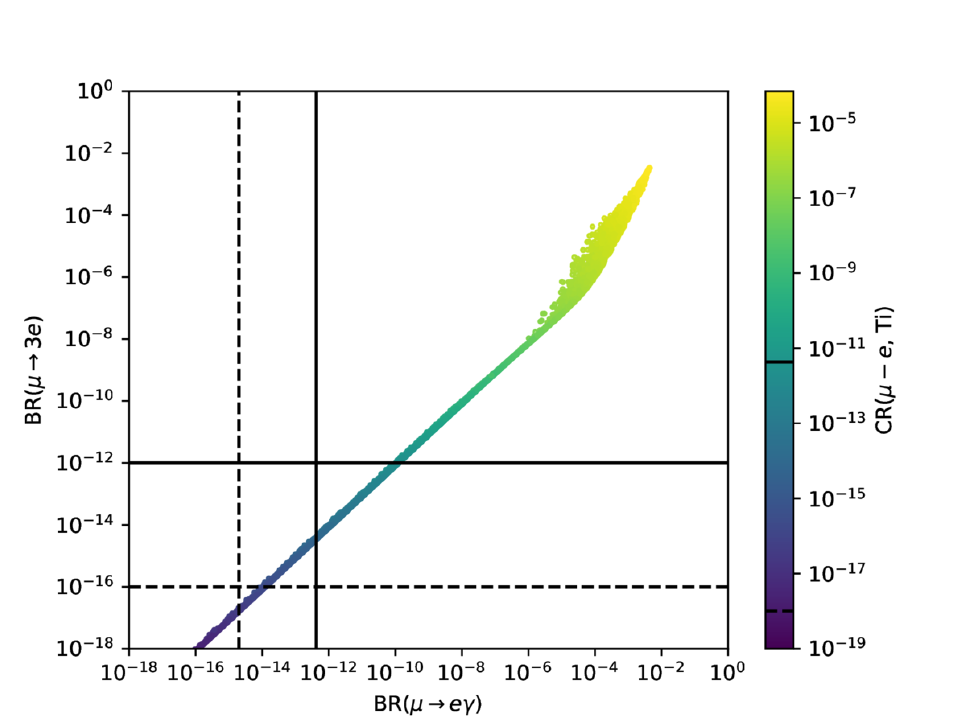
Figure 6 . Branching ratio of the lepton (cid:13)avour violating process (cid:22) ! 3 e versus the one of the (usually most constraining) process (cid:22) ! e(cid:13) . The rate of muon conversion in the (cid:12)eld of titanium atoms (cid:22) (cid:0) Ti ! e (cid:0) Ti is shown on a colour scale. Also shown are the current (solid black lines) [69, 71, 72] and expected future (dashed black lines) [70, 73, 74] experimental limits on the branching ratios and conversion